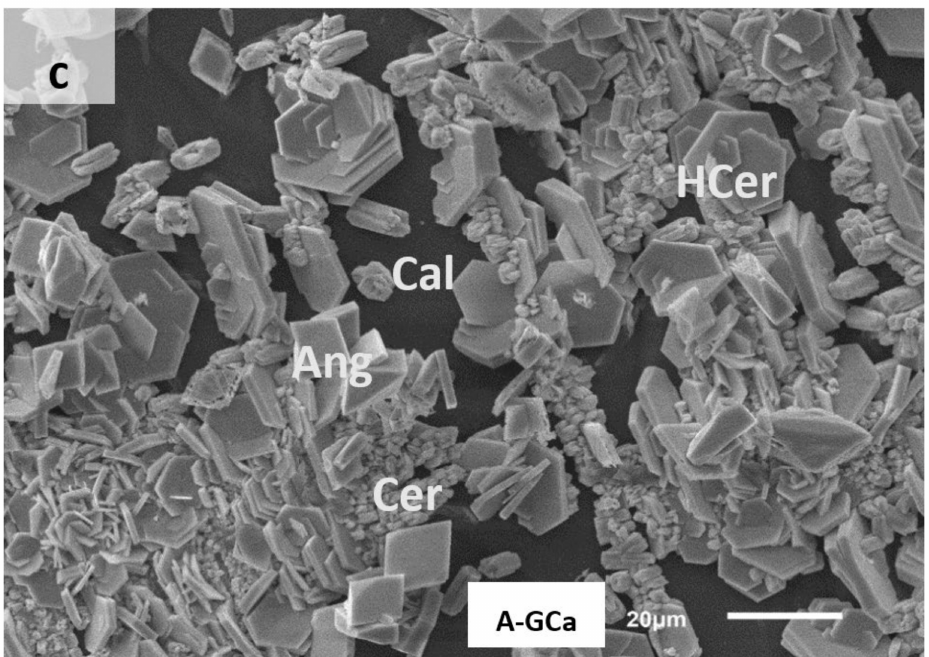
Figure 10. SEM micrographs of phases newly formed after 24 h of interaction between Pb-bearing solutions and mixtures of gypsum and calcite. ( a ) A continuous layer of anglesite crystals (Ang) carpet gypsum surfaces interacting with solutions with [Pb] i = 10 mM. ( b ) The surface of calcite crystals (Cal) interacting with solutions with [Pb] i = 1 mM appears covered by discontinuous patches consisting of hydrocerussite (HCer). ( c ) The surface of calcite crystal interacting with solutions with [Pb] i = 10 mM appears covered by a discontinuous layer of closely intergrown hydrocerussite (HCer) plates and cerussite (Cer) prismatic crystals. A small number of anglesite (Ang) crystals can also be observed scattered on the